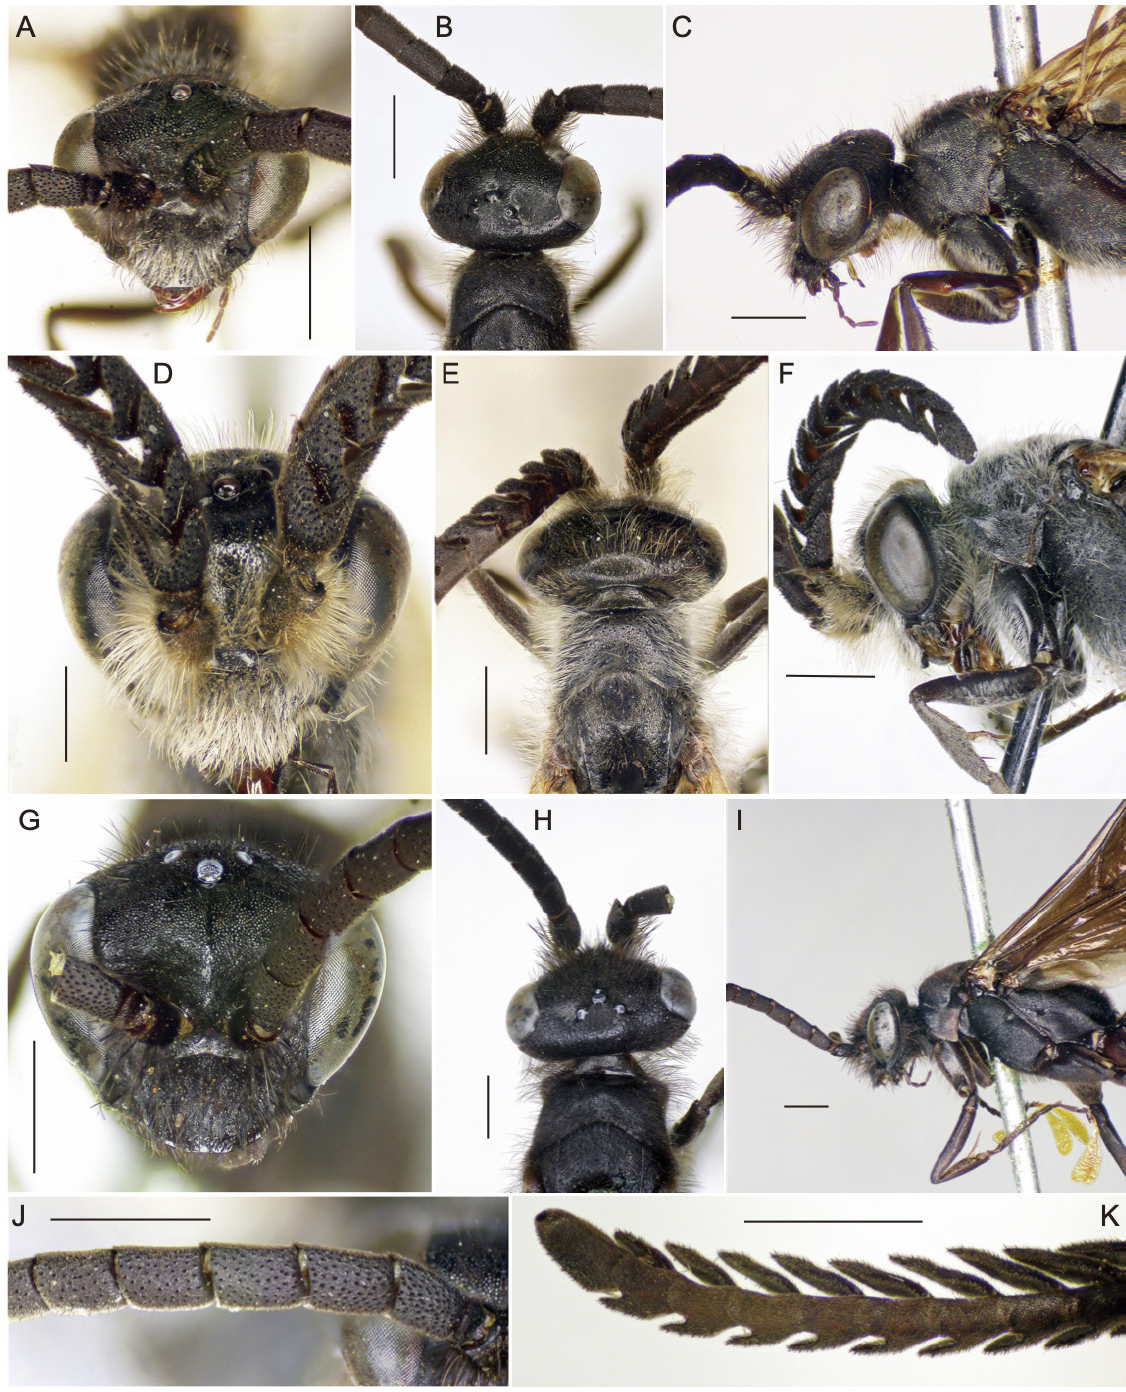
Fig. 8. Males of Paraclavelia Haupt, 1930. A–C, J . P. katbergensis Arnold, 1948 (#29) (NHMUK). D–F, K . P. decipience (Arnold, 1932) (#28) (UMUT). G–I . P. crudelis (Smith, 1879) (#26) (NHMUK). A, D, G . Head, anterior view. B, E, H . Head and anterior part of mesosoma, dorsal view. C, F, I . Head and mesosoma, lateral view. J . Right antenna, anterior view. K . Right flagellum, dorsal view. Numbers in parentheses after species names are specimen numbers in Supp. file 1. Scale bars = 1